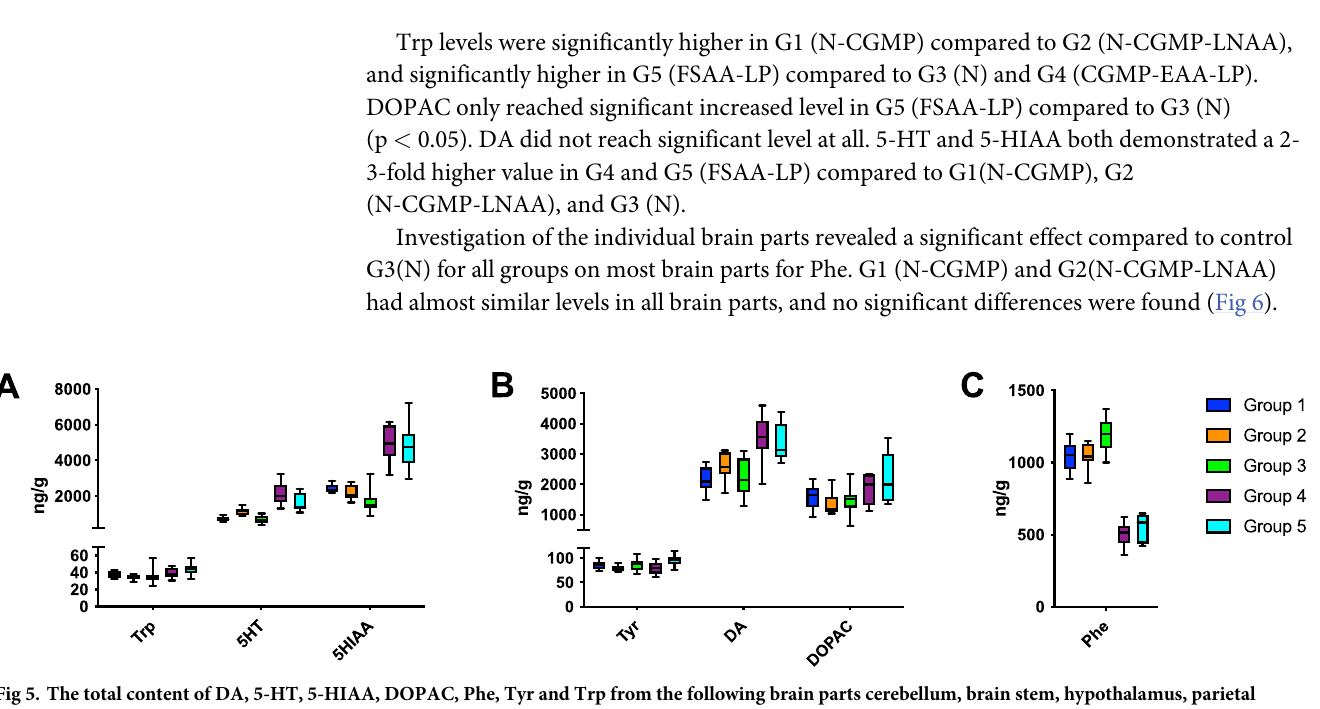
Fig 5. The total content of DA, 5-HT, 5-HIAA, DOPAC, Phe, Tyr and Trp from the following brain parts cerebellum, brain stem, hypothalamus, parietal cortex, anterior piriform, cortex and olfactory bulb (presented as total brain by ading values for the individual brain parts together). Trp is metabolized to 5-HT in the brain and finally further metabolized mainly to 5-HIAA. Tyr is precursor of DA which is further converted to DOPAC. Group 1–5 represent: G1(N-CGMP), G2 (N-CGMP-LNAA), G3 (N), G4 (CGMP-EAA-LP) and G5 (FSAA-LP).